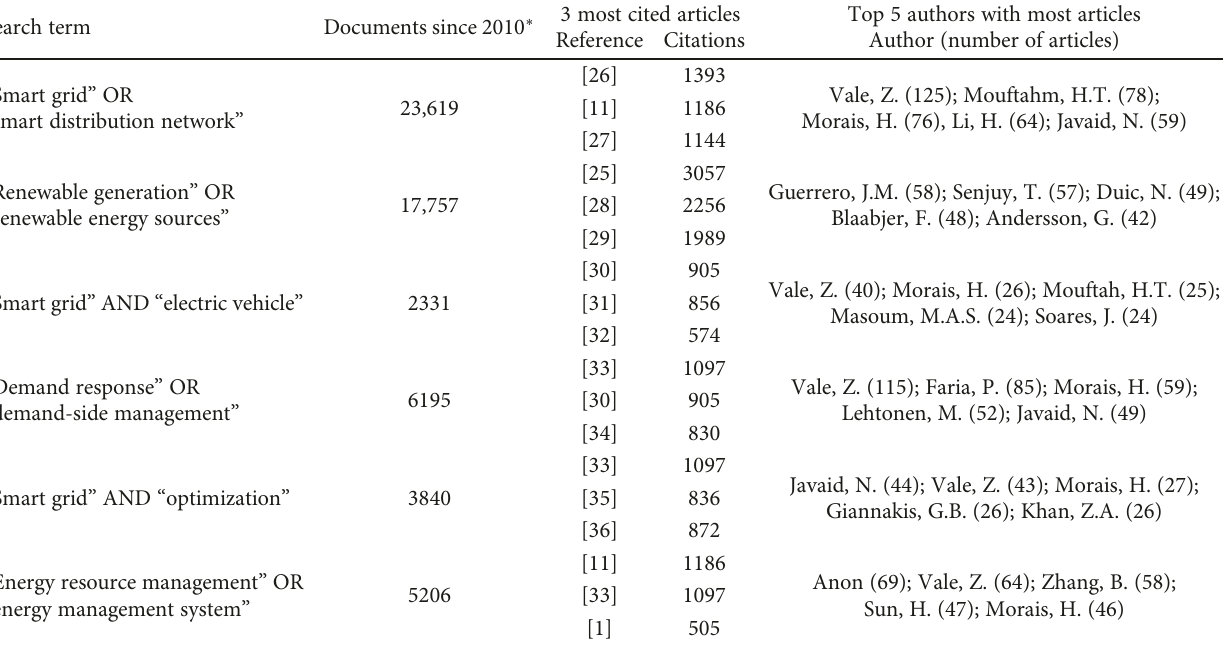
Table 1: Research documents produced since 2010 analyzed by search term according to